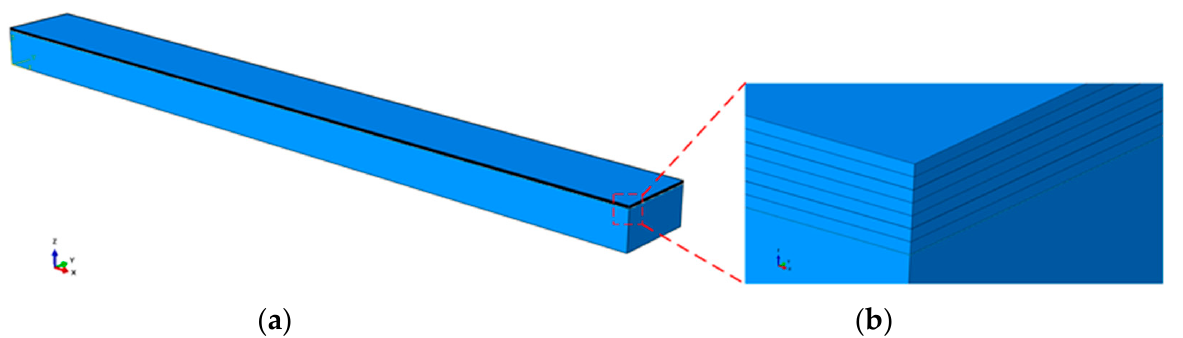
Figure 5. CAE model of thin-walled GH4169 workpiece with residual stress layer. ( a ) CAE model of the thin-walled workpiece; ( b ) layer affected by residual stress. The length and width of the thin-walled workpiece model are 40 mm and 4 mm, respectively. The simulation cases and their parameters are shown in Table 2. Table 2. Simulation cases and